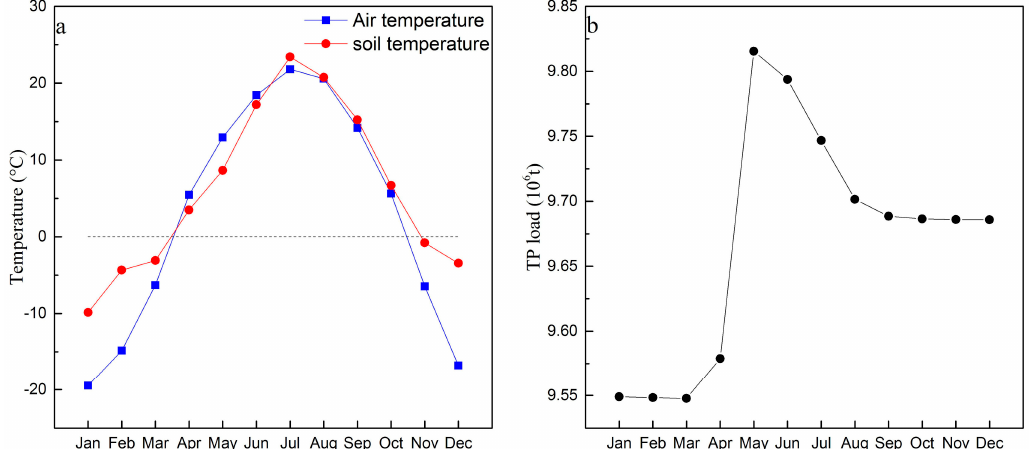
Figure 11. Monthly air and soil temperatures ( a ); and total phosphorus (TP) load ( b ). Water 2016 , 8 , 505